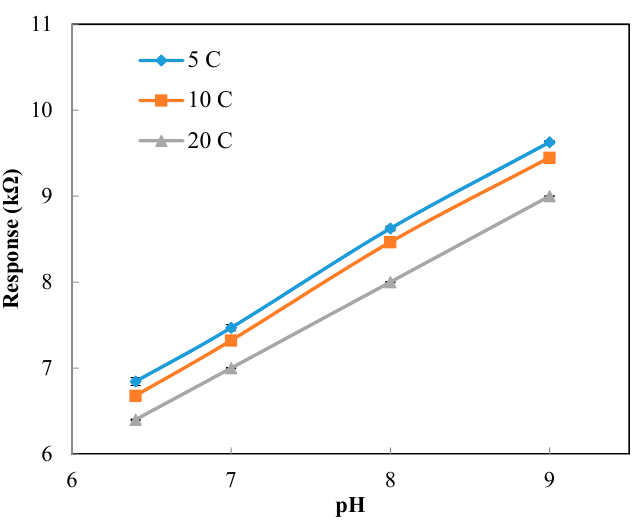
Figure A3. Calibration curve for the pH sensor at the static condition for different temperatures.